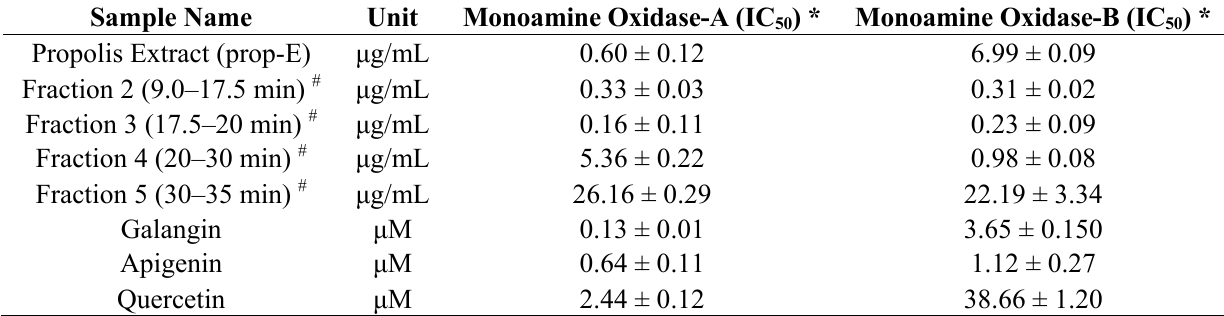
Table 1. Inhibition of recombinant human Monoamine Amine Oxidase-A and B by propolis extract, fractions and pure